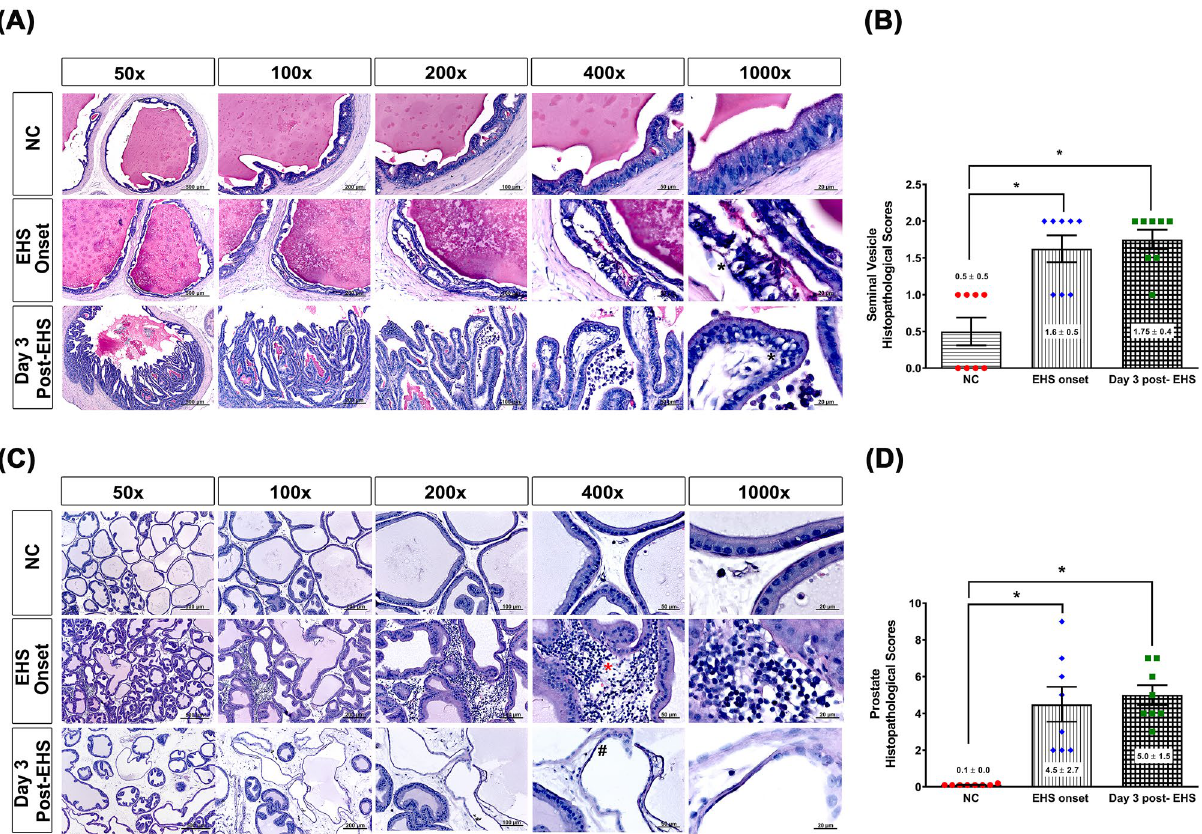
Figure 5. Histological alterations and quantitative analysis of rat seminal vehicle and prostate tissues from the three groups. ( A ) Representative histological images are presented, following hematoxylin and eosin staining of the seminal vesicle of rats from the NC, EHS onset, and Day 3 post-EHS. The EHS rats had many pyknosis cells (black stars) in their seminal vesicle tissues. ( B ) The right panel denotes a quantitative analysis of the histological alterations in the different groups. ( C ) Representative histological images of the prostates of rats from the NC, EHS onset, and Day 3 post-EHS. The red star indicates inflammatory cells in the rats’ prostate tissues, and the black # indicates the interstitial edema in the rats’ prostate tissues. ( D ) The right panel denotes a quantitative analysis of the histological alterations in the different groups. Images of the seminal vehicle and prostate morphology are shown at ×50, ×100, ×200, ×400 and ×1000 magnification. Scale bars = 500 μm, 200 μm, 100 μm, 50 μm, and 20 μm. Data are presented as the mean ± standard deviation (n = 8 per group). *P < 0.05, EHS onset vs. NC or Day 3 post-EHS vs.